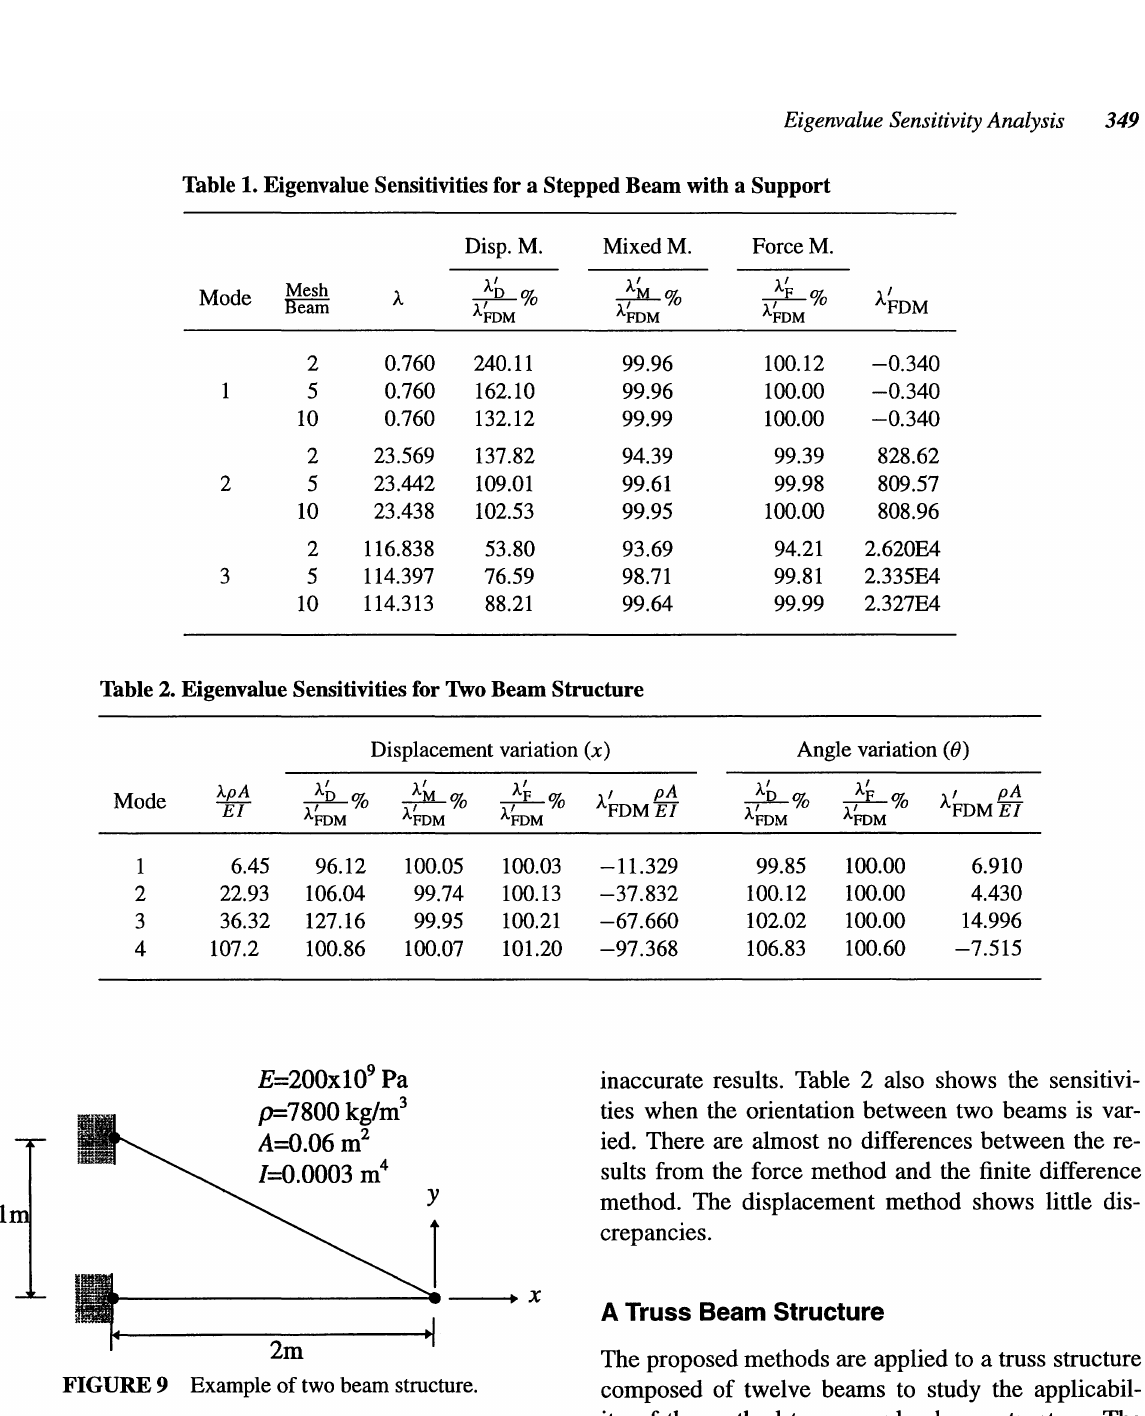
FIGURE 9 Example of two beam